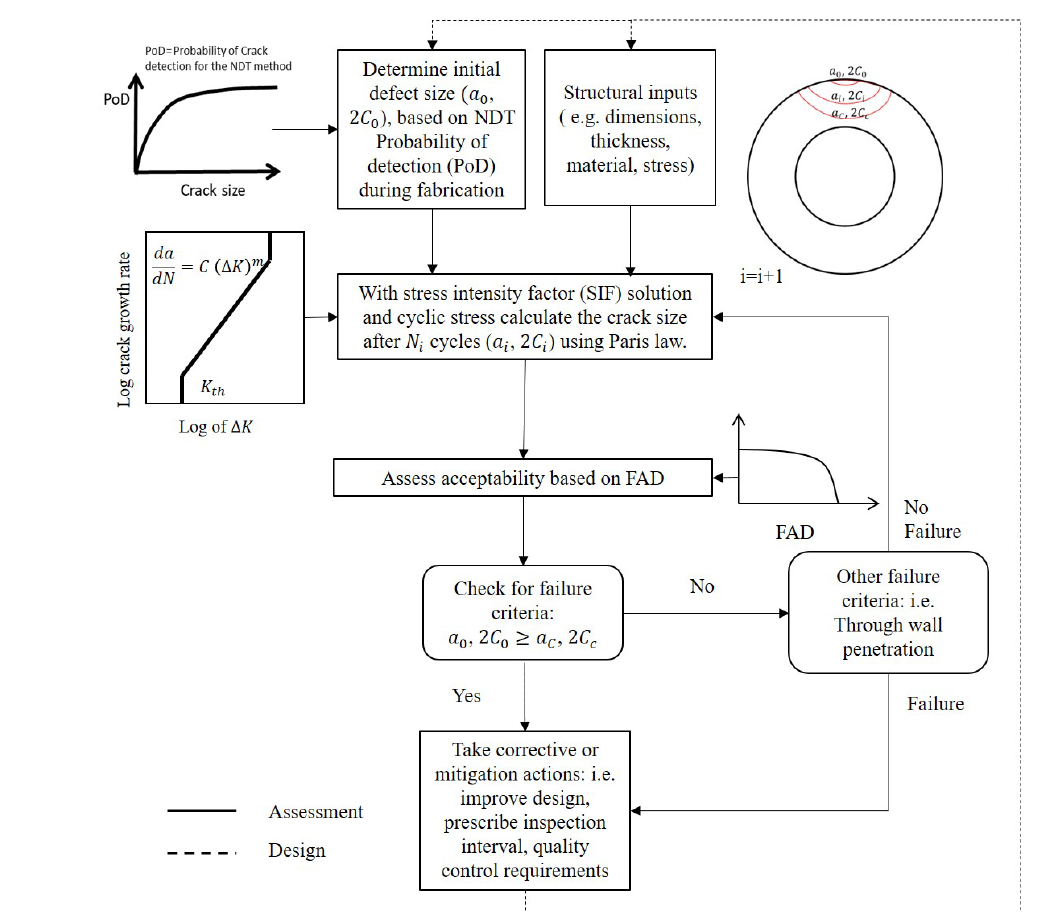
Figure 8. Fracture mechanics flow diagram for assessment and design of structures against fatigue failure.